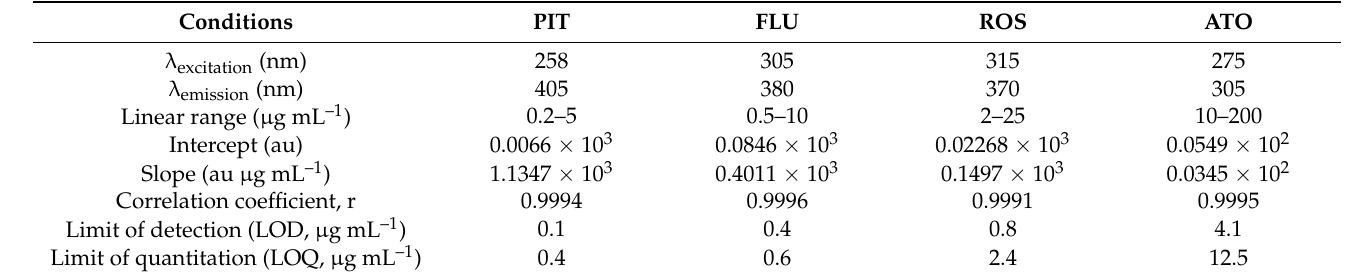
Table 3. The optimum conditions of the proposed MW-SFA for statins and its analytical parameters.